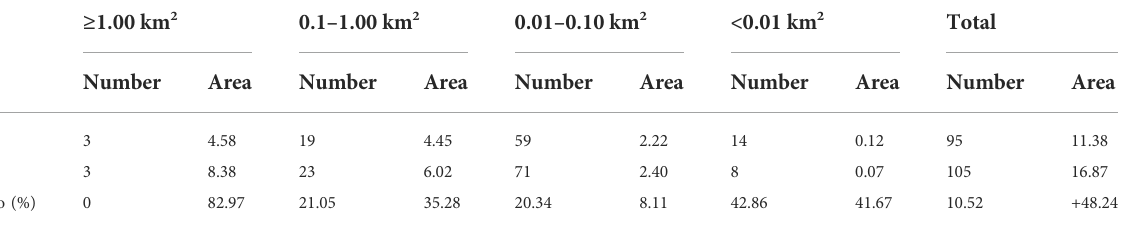
TABLE 4 Number and area of moraine-dammed glacial lakes in 2000 and 2019.